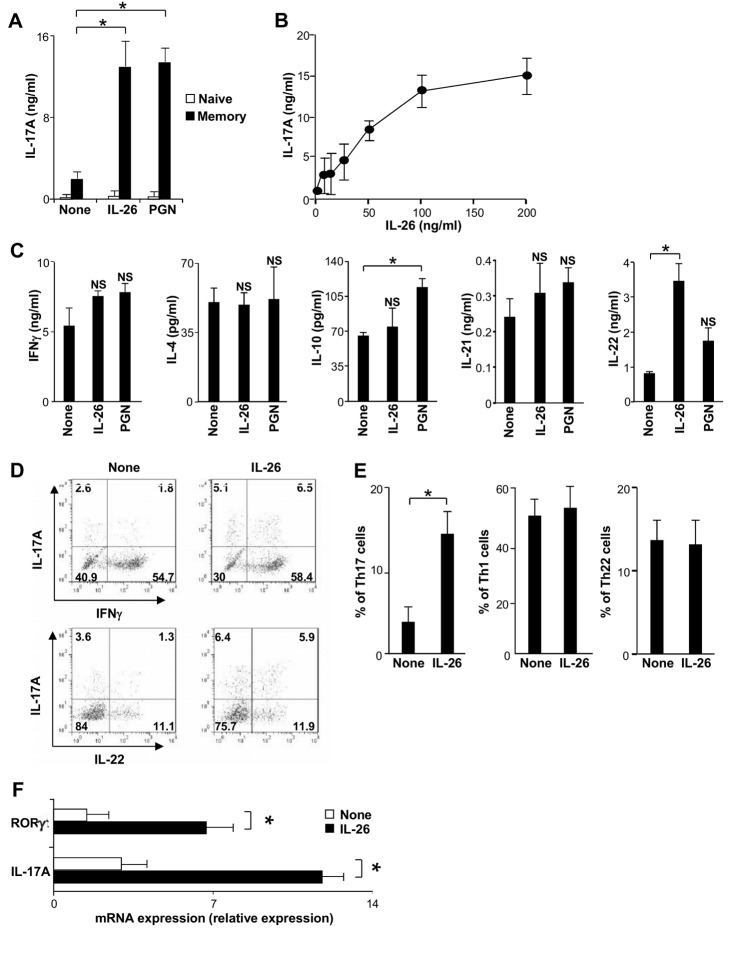
IL-26 upregulates IL-17A secretion by memory CD4+ T cells.(A) Naive or memory CD4+ T cells were stimulated by an anti-CD3 mAb, in the presence of monocytes, with or without 50 ng/ml IL-26 or 5 µg/ml PGN. IL-17A was quantified by ELISA in the 7-d supernatants. (B) Memory CD4+ T cells were stimulated by an anti-CD3 mAb, in the presence of monocytes, with or without IL-26 at the indicated concentrations. IL-17A was quantified in the 7-d supernatants. (C) Memory CD4+ T cells were stimulated as described, with or without 50 ng/ml IL-26. IFN-gamma, IL-4, IL-10, IL-21, and IL-22 were quantified by ELISA in the 7-d supernatants. (A–C) Results are expressed in ng/ml or pg/ml (mean ± SD, n = 5). (D and E) Memory CD4+ T cells, stimulated for 7 d by an anti-CD3 mAb in the presence of monocytes, with or without 50 ng/ml IL-26, were further cultured for 7 d. Then, cells were stimulated by PMA plus ionomycin and intracellular expression of IL-17A, IL-22, and IFNγ was analyzed by flow cytometry. (D) Dot plots are representative of one out of five experiments; (E) Results are expressed as a percentage of Th17- (IL-17A+), Th1- (IFN-gamma+ IL-17A−), or Th22- (IL-22+ IL-17A−) expressing cells (mean ± SD, n = 4). (F) Memory CD4+ T cells were stimulated by an anti-CD3 mAb in the presence of monocytes, with or without 50 ng/ml IL-26. At day 7, T cells were purified and IL-17A and RORgamma t mRNA expression was analyzed by RT-qPCR. Results are expressed as a relative mRNA expression level (mean ± SD, n = 4). *p<0.05 (Wilcoxon matched-pairs signed-ranks test).